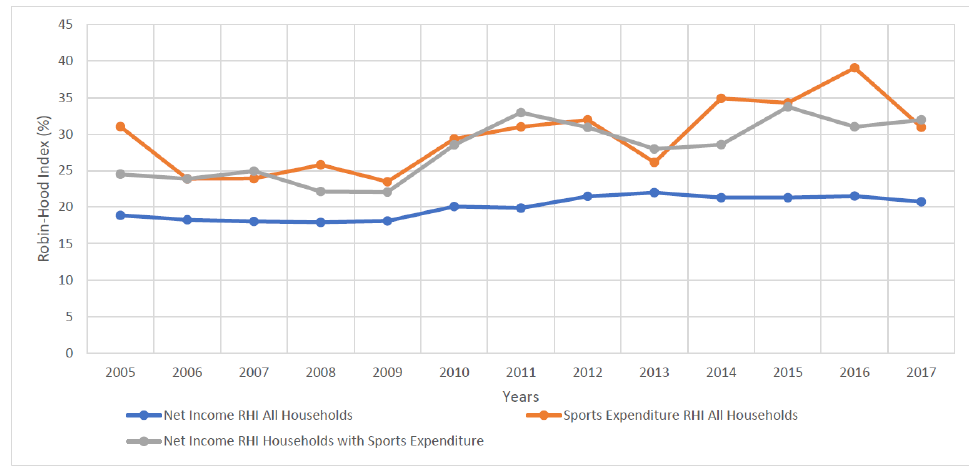
Figure A6. Robin-Hood inequality indices in the time period 2005–2017. Source: own calculation. Table A3. Correlation (and p -value) of net income inequality distribution indices between 2005 and 2017, all households.